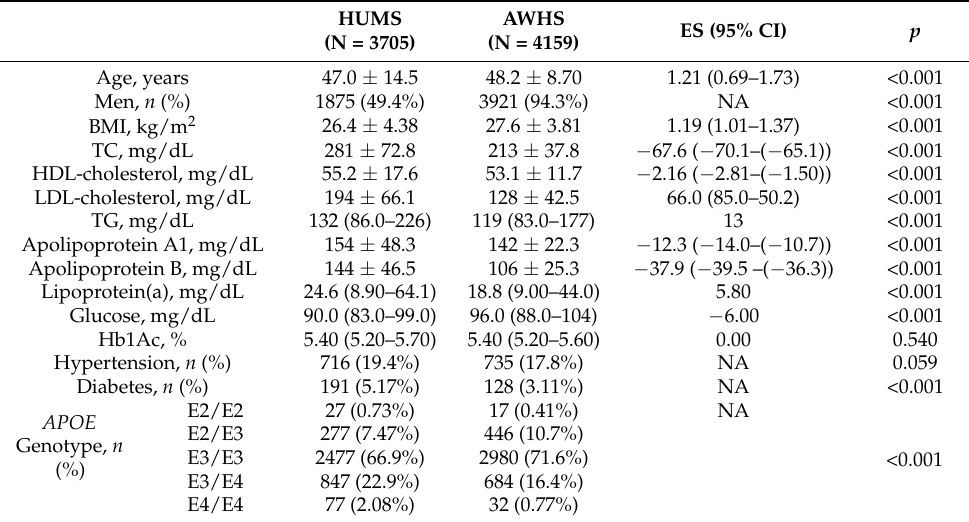
Table 1. Clinical and biochemical characteristics in both cohorts.